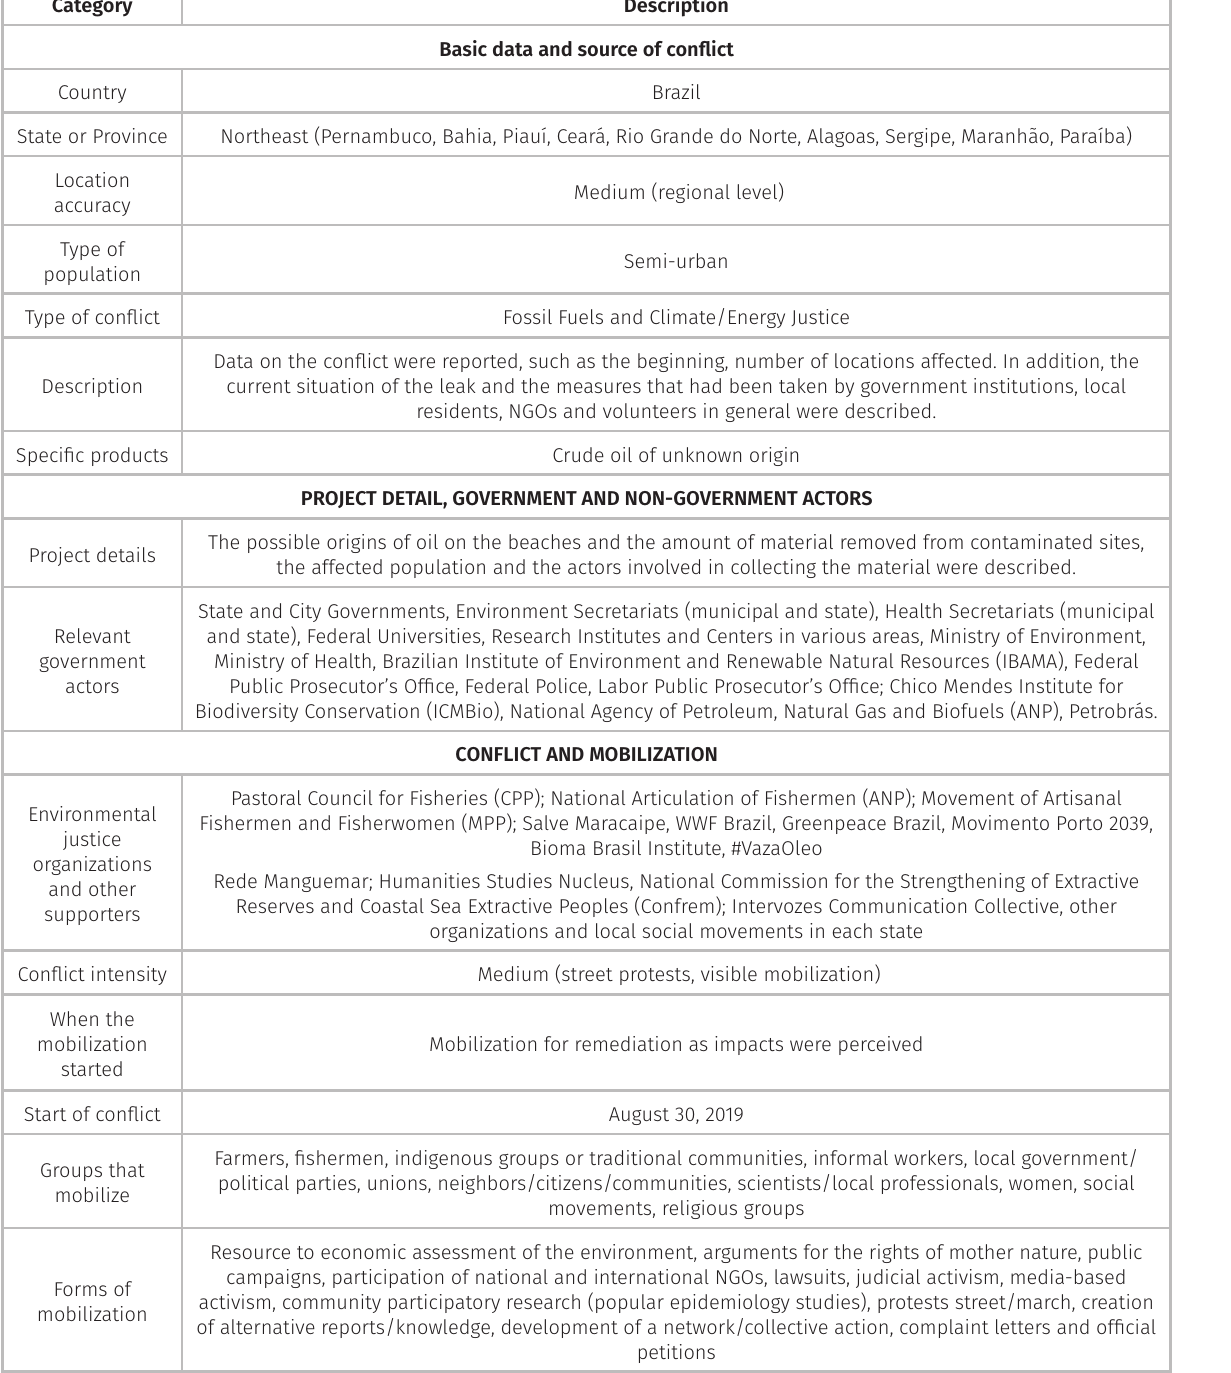
Table III. Conflicts’ mapping and socio-environmental impacts from the oil spill on the Brazilian Northeast Coast. Category Description Basic data and source of conflict Country Brazil State or Province Location Medium (regional accuracy